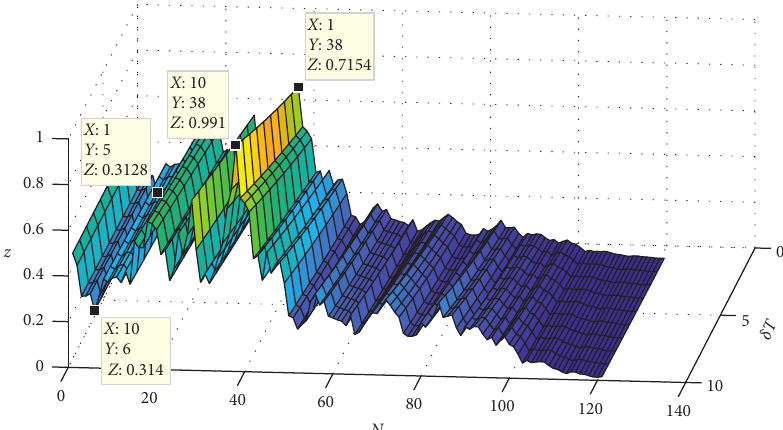
) on the enterprises’ innovation strategy adoption. 1